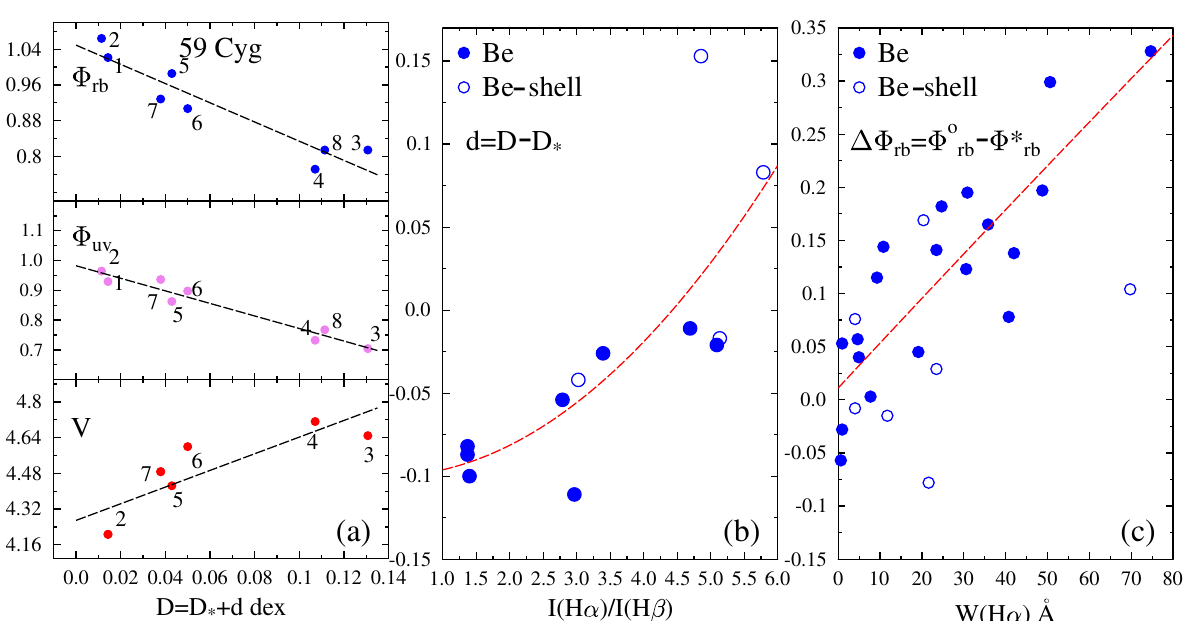
Figure 5. ( a ) Variation of gradients Φ rb , Φ uv and magnitude V against the total BD of 59 Cyg from 1948 to 1981 (1: Spt.48, 2: Oct.65, 3: Jul.77, 4: Nov.77, 5: Jun. 79, 6: Nov.79, 7: Jul.80, 8: Spt.81). ( b ) Second component d of the BD against the Balmer line decrement I ( H α ) / I ( H β ) . ( c ) Reddening and bluing of the gradient Φ rb corrected from ISM extinction against the equivalent width of the emission component of H α . In ( b , c ), filled circles are for Be phases and open circles for Be-shell phases of Be